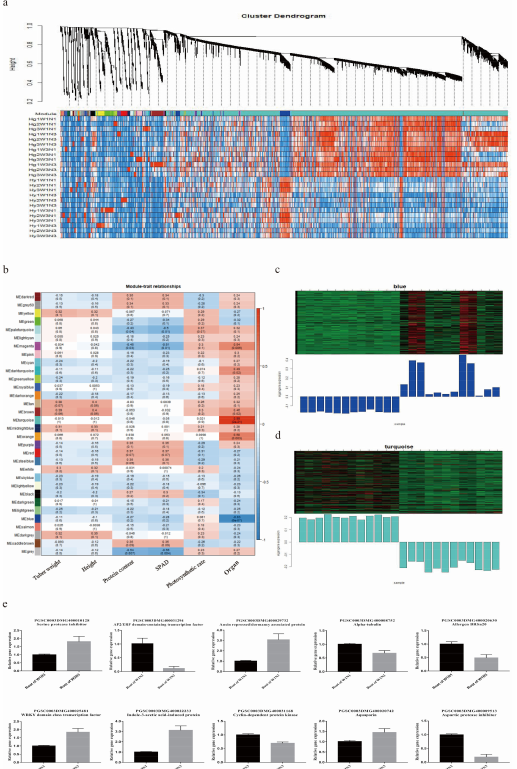
Figure 5. Key candidate water- and nitrogen-responsive genes screened with weighted gene co- expression network analysis (WGCNA). ( a ) Hierarchical cluster tree showing co-expression modules identified by WGCNA. Upper, gene cluster tree; each branch corresponds to a module. Lower, gene heatmap; rows represent all genes in a module, and columns represent samples. ( b ) Module–trait associations from WCGNA. For each cell, the upper number is the Pearson correlation coefficient, and the lower number is the significance value. ( c ) Upper, expression of each gene in the blue module in each sample. Each row represents all genes in the module, and each column represents a sample. Lower, expression level of the blue module in each sample. ( d ) Upper, gene expression of each gene in the turquoise module in each sample. Each row represents all genes in the module, and each column represents a sample. Lower, expression level of the turquoise module in each sample. ( e ) Ten candidate water- and nitrogen-responsive genes were selected randomly for RT-PCR